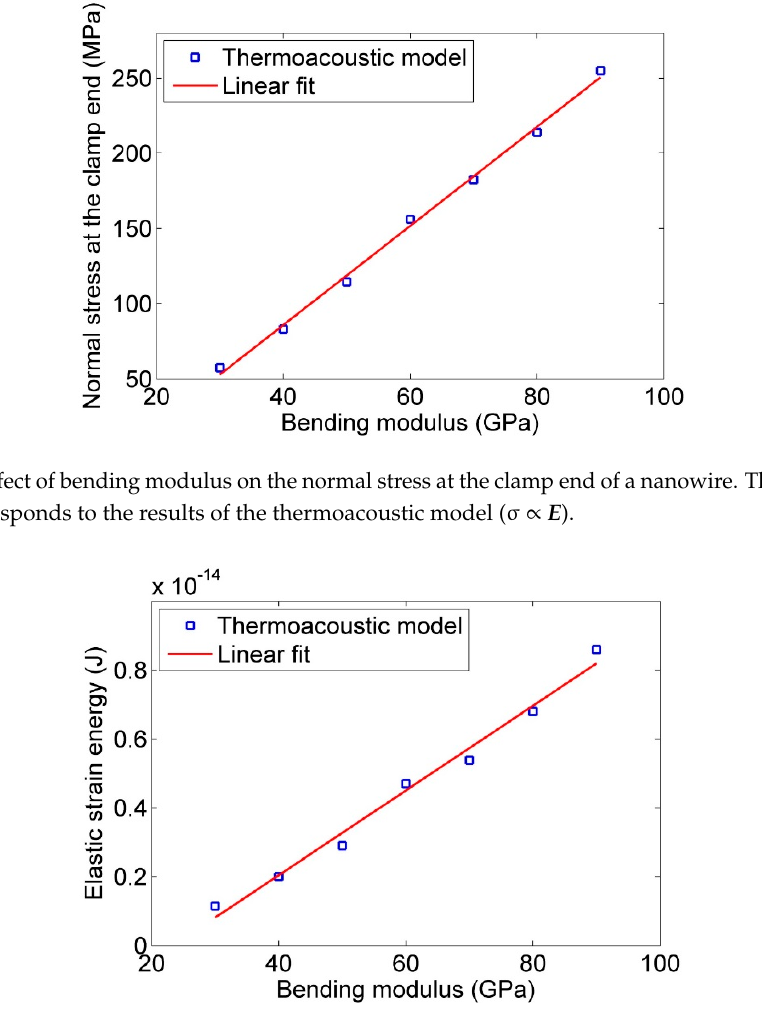
Figure 10. Effect of bending modulus on the elastic strain energy of nanowire. The analytical model matches with the results of a thermoacoustic model ( V ∝ E ).